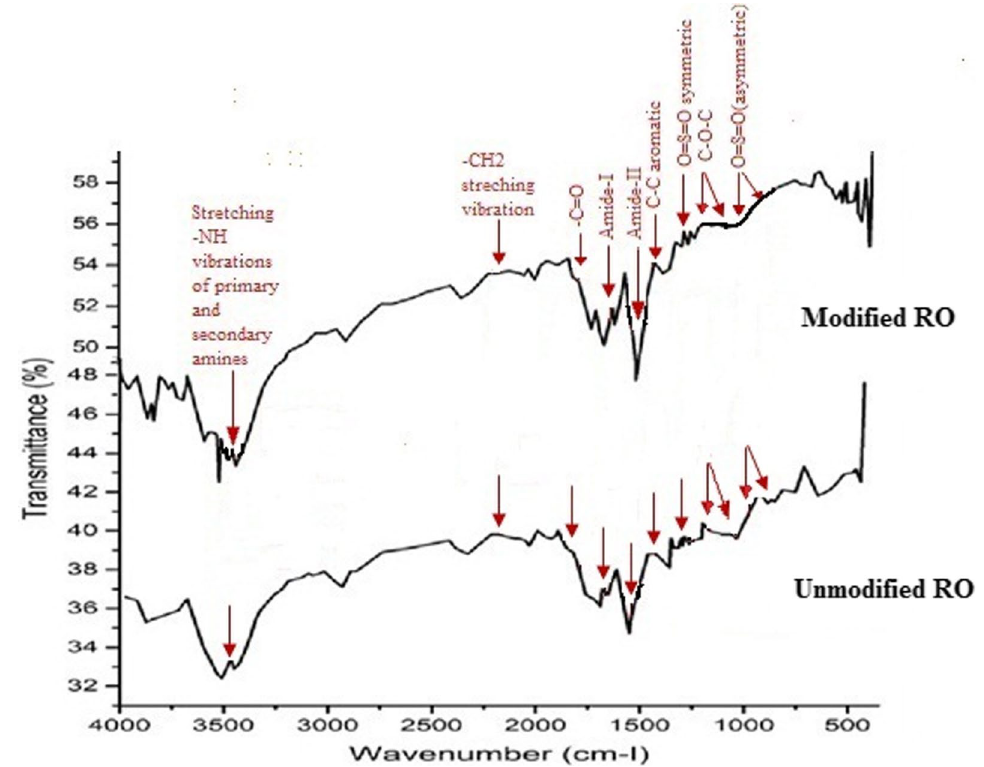
Fig. 5 FTIR analysis of a pristine and b modified RO